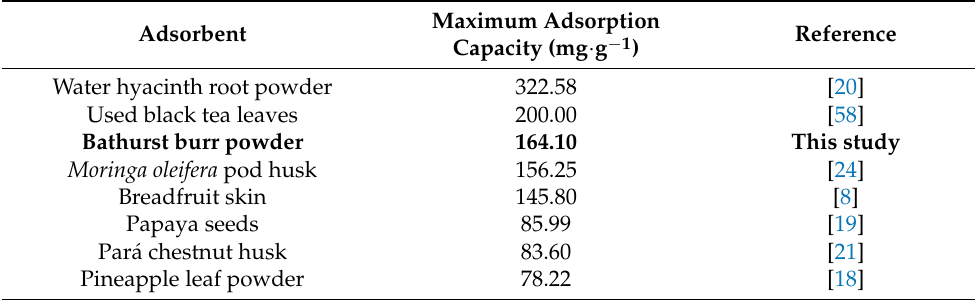
Table 4. Maximum adsorption capacities values of similar adsorbents used for the crystal violet dye